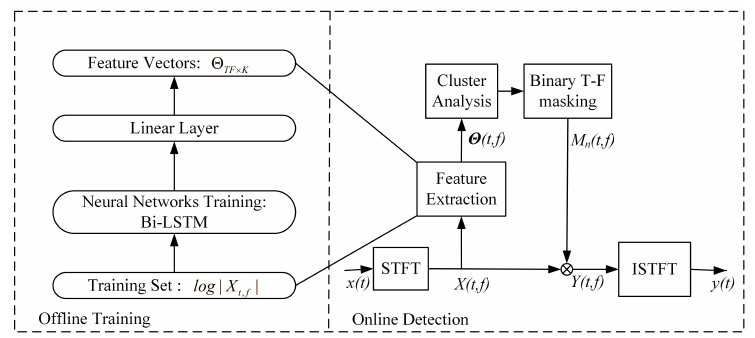
Figure 2. Framework of proposed